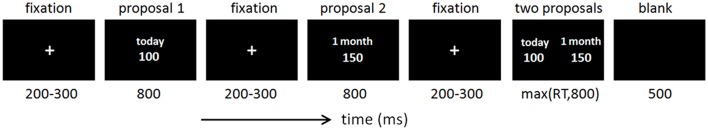
Illustration of the delay discounting paradigm in this study.